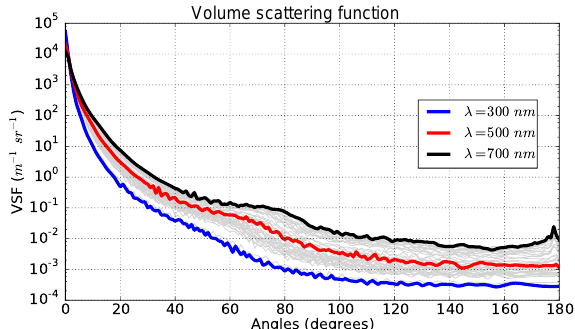
Figure 11. Volume scattering function using the estimated refrac- tive index for spherical-shaped coated